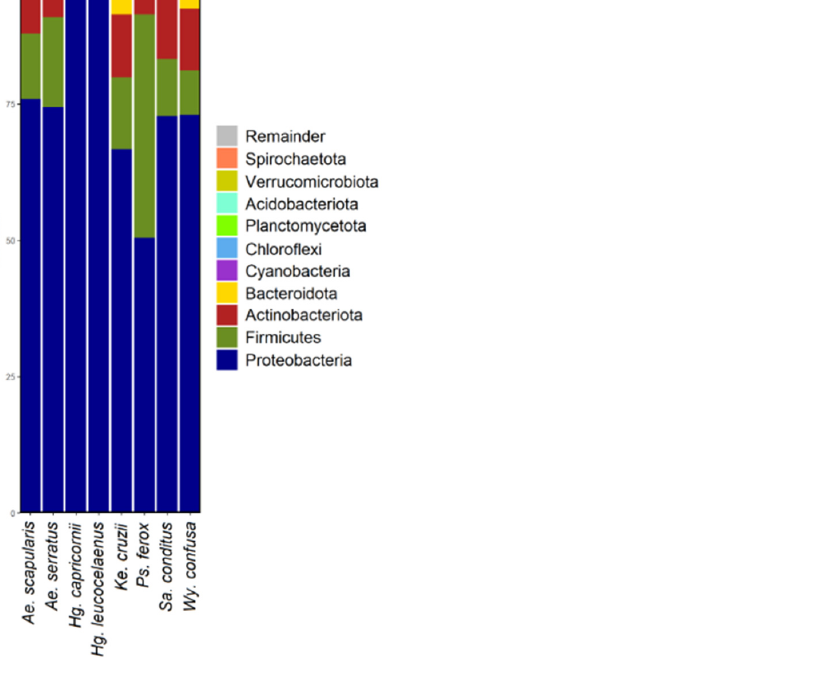
Figure 1. Bar graph depicting the bacterial amplicon sequence variants (ASV) composition at the highest taxonomic level (phylum) for each mosquito species.